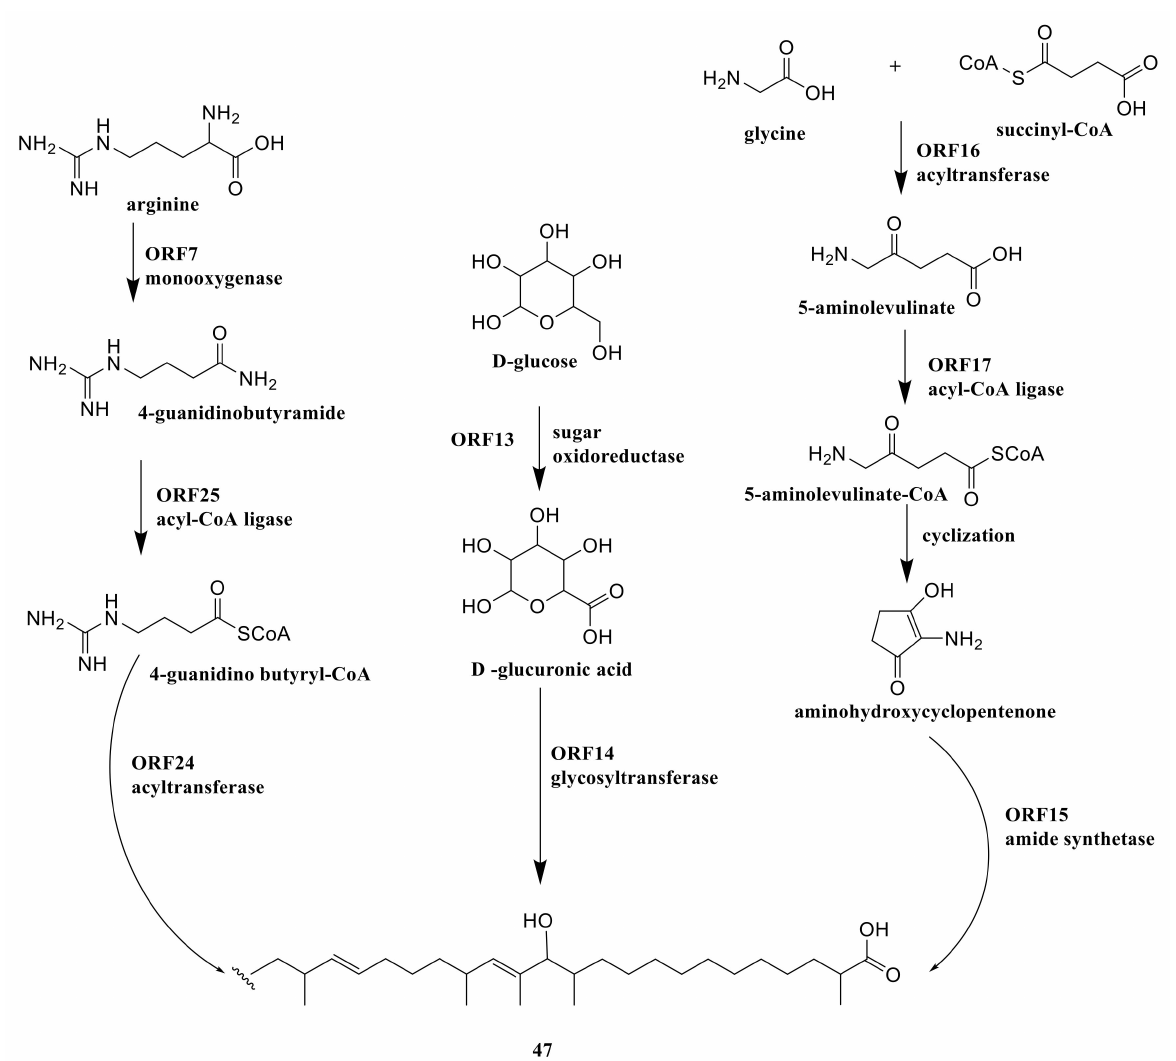
Figure 9. The biosynthetic pathway of ECO-0501 ( 47 ) [24]. The genome of Amycolatopsis sp. HCa4 was analyzed by antiSMASH and 2ndfind, the cluster 19 was highly similar to the biosynthetic gene cluster of rifamycin [29]. A 3- amino-5-hydroxybenzoic acid starter unit and two malonyl CoA and eight methyl malonyl CoA extender units could produce intermediate 1 on a type I polyketide synthase. The re- lease of the polyketide chain and the formation of intramolecular amide were catalyzed by the amide synthase encoded by Rmp F and then generated proansamycin X (intermediate 2). Proansamycin X was then catalyzed by a serious of enzymes encoded by Rmp T,